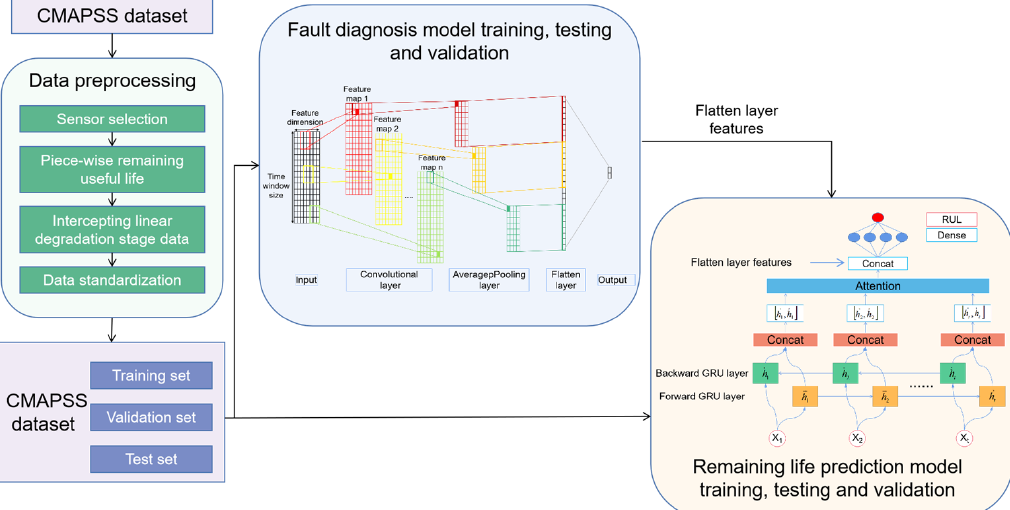
Figure 3. The flow chart of the proposed method experiment.